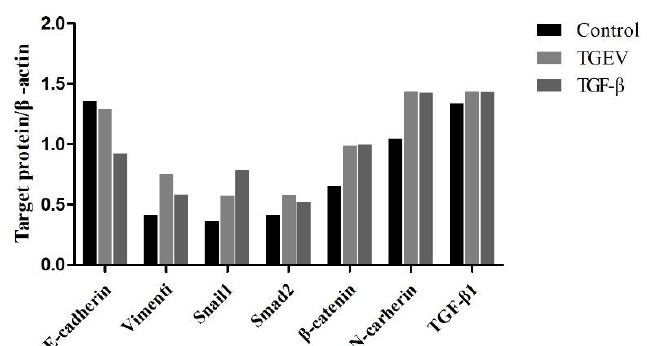
Figure A4. Gray analysis of western blot in Figure 4.